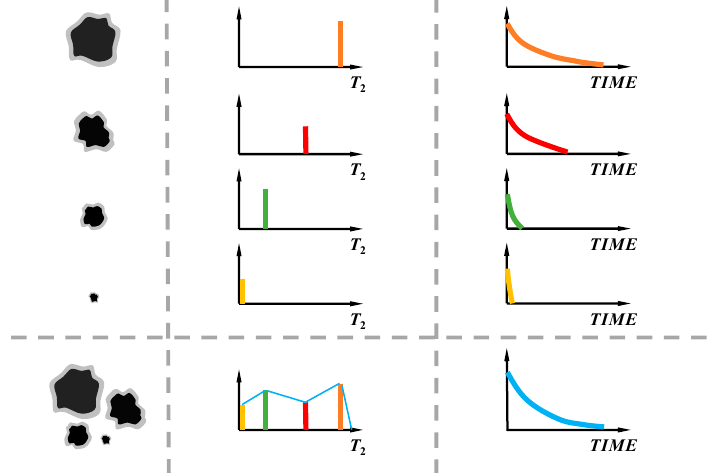
Figure 1. Multiple indexes decay for fluid NMR T 2 .